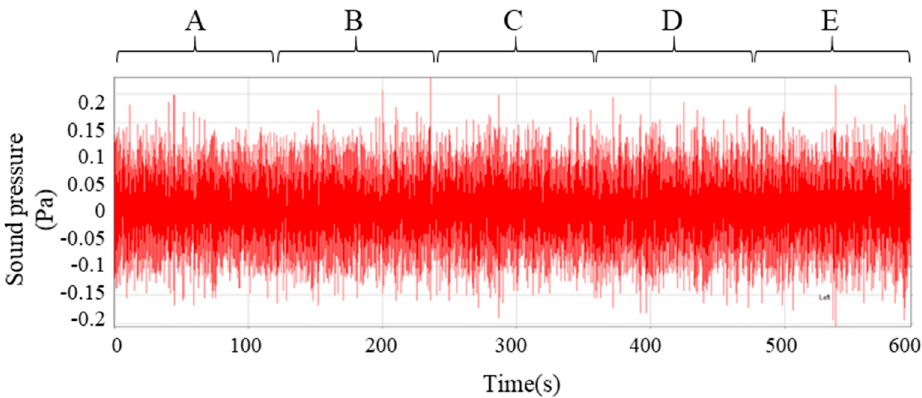
Figure 2. Measurements of refrigerant flow noise. Table 1. First- and second-order moments of refrigerant flow noise.